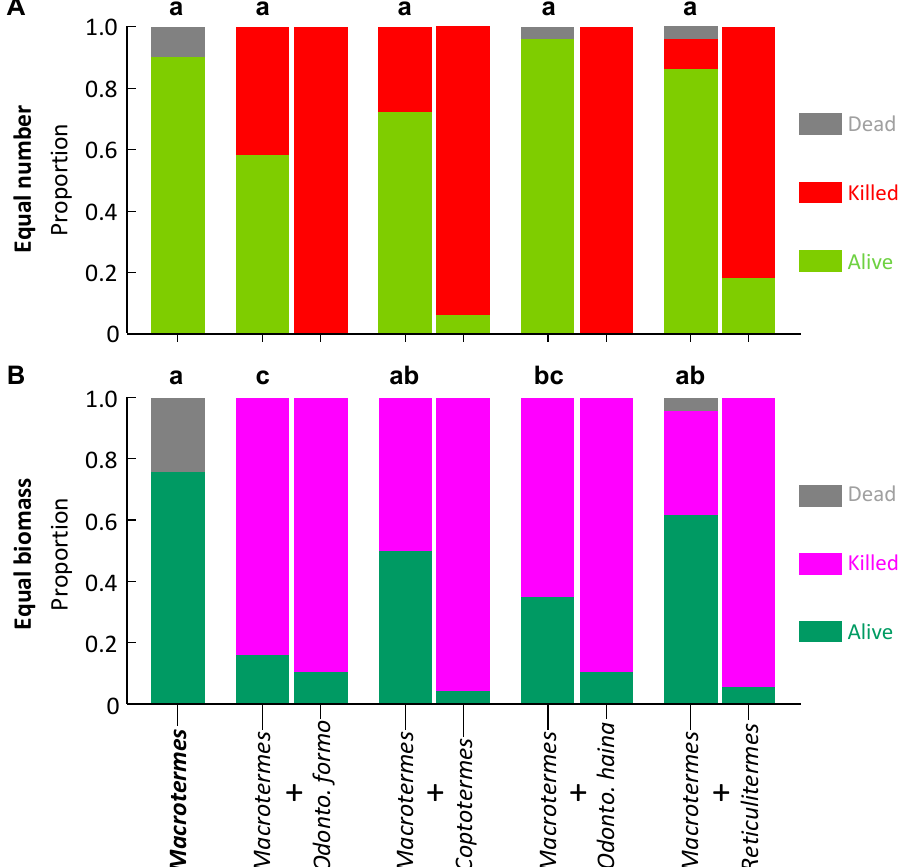
Figure 1. Survival of Macrotermes barneyi in laboratory aggression experiments. The control appears as a single column as it contains one species, whereas paired species treatments are paired columns, the M. barneyi on the left of each pair. Columns surmounted by di ff erent letters signify significantly di ff erent proportion survival (Bonferroni corrected pairwise comparisons) for M. barneyi . ( A ) Equal number of termites; ( B ) Equal biomass of termites.